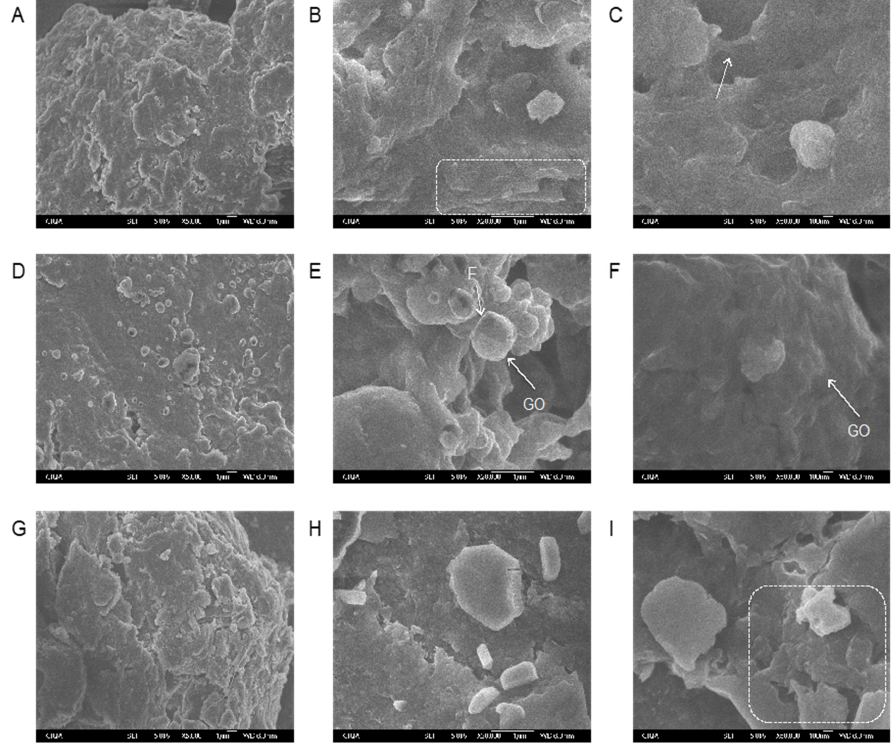
Figure 6. Scanning electron microscopy (SEM) micrographs of rGO S ( A – C ), rGO F ( D – F ), and rGO M ( G – I ) nanohybrids at 5000, 20,000, and 50,000 × .